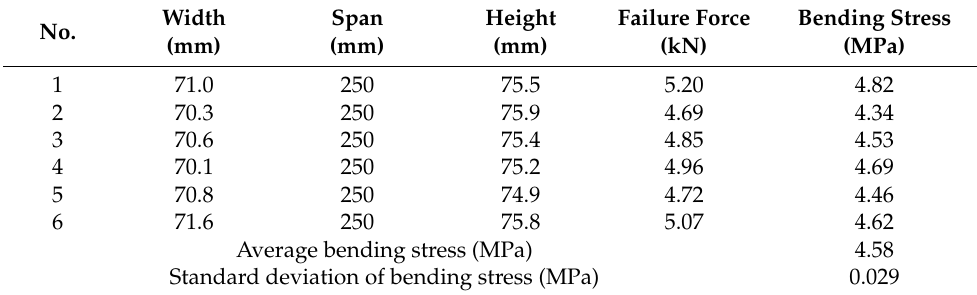
Table 3. Flexural strength of concrete beams under the three-point bending test.